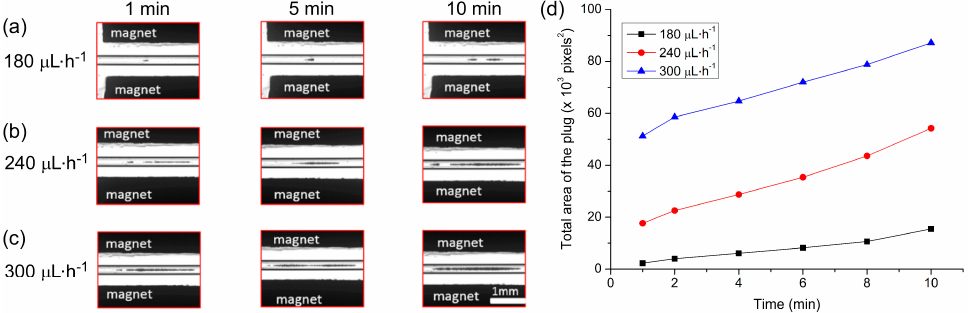
Figure 4. The effect of flow rate on magnetic particle plug formation. ( a – c ) Photographs of plug formation at time points of 1, 5 and 10 min for flow rates of: ( a ) 180 µL·h − 1 ; ( b ) 240 µL·h − 1 ; and ( c ) 300 µL·h − 1 . ( d ) Plot of measured plug sizes over time at the three different flow rates. Each pixel was approximately equivalent to an area of 5.6 µm 2 .